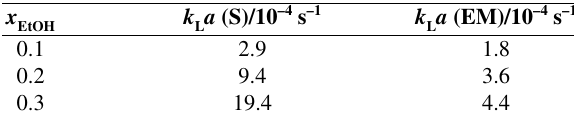
a products, at different hete- L